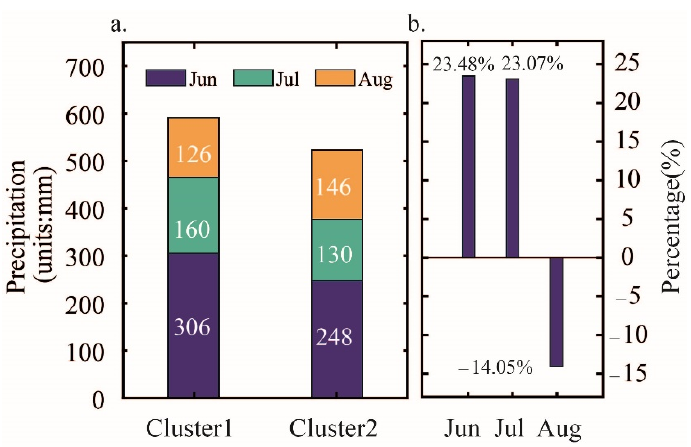
Figure 6. Differences of the mean sub-seasonal precipitation in June, July, and August between two precipitation clusters in the Poyang Lake basin during 1961–2016. ( a ) the mean precipitation magnitude of C1 and C2. ( b ) Percentage in June, July, and August.